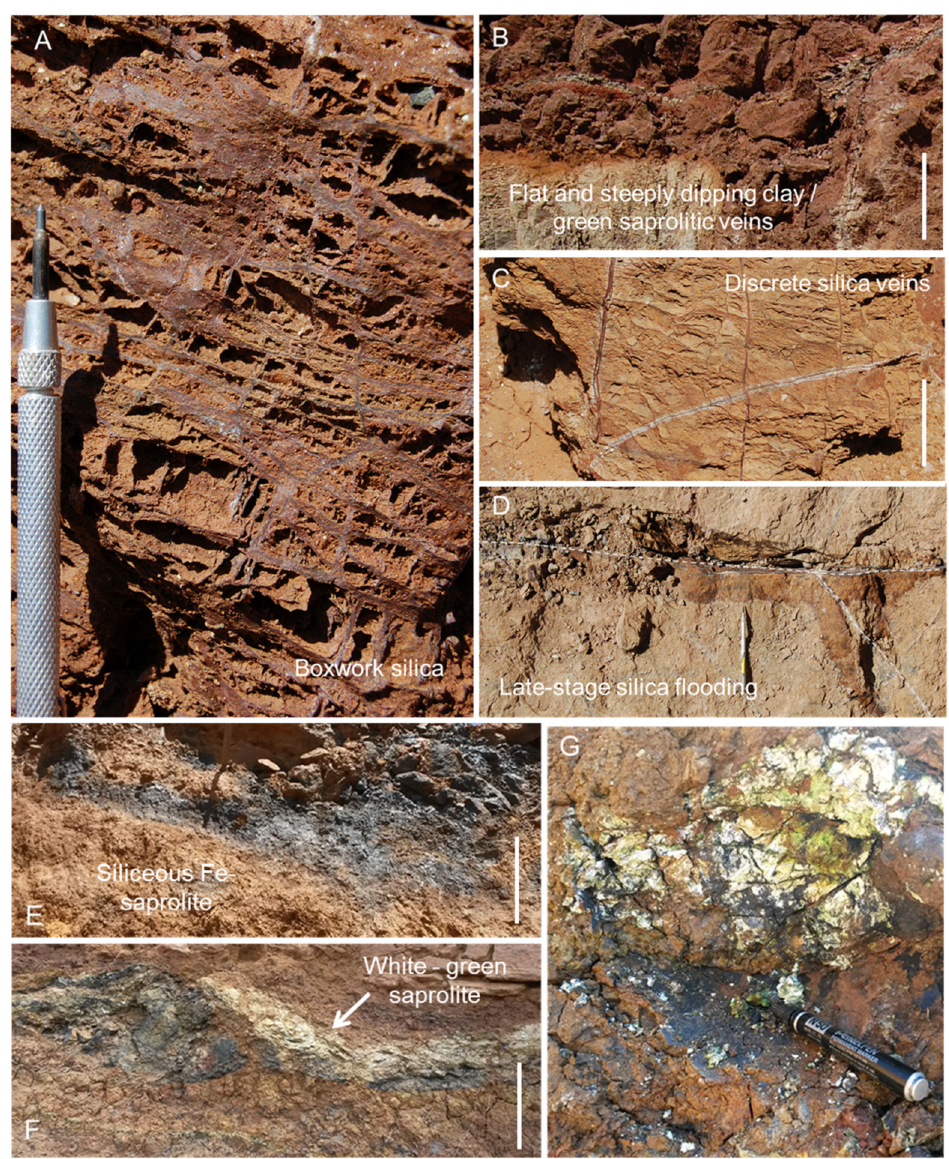
Figure 4. Veining and boxwork textures from the saprolite units observed in the profile of the Piau í deposit ( A ) Finely meshed silica boxwork within the silicified Fe-saprolite. ( B ) Flat and steeply dipping, clay-rich, green saprolite veins commonly observed throughout the ferruginous saprolite units. Scale bar is 30 cm. ( C ) Discrete fine-scale silica veining within the silicified ferruginous saprolite. Scale bar is 15 cm. ( D ) Silicification within the silicified ferruginous saprolite facilitated by the discrete fine-scale, late-stage silica veins. ( E – G ) Examples of black mineral aggregates and coatings associated with the white-green saprolitic layers. Scale bar is 50 cm in ( E ) and ( F